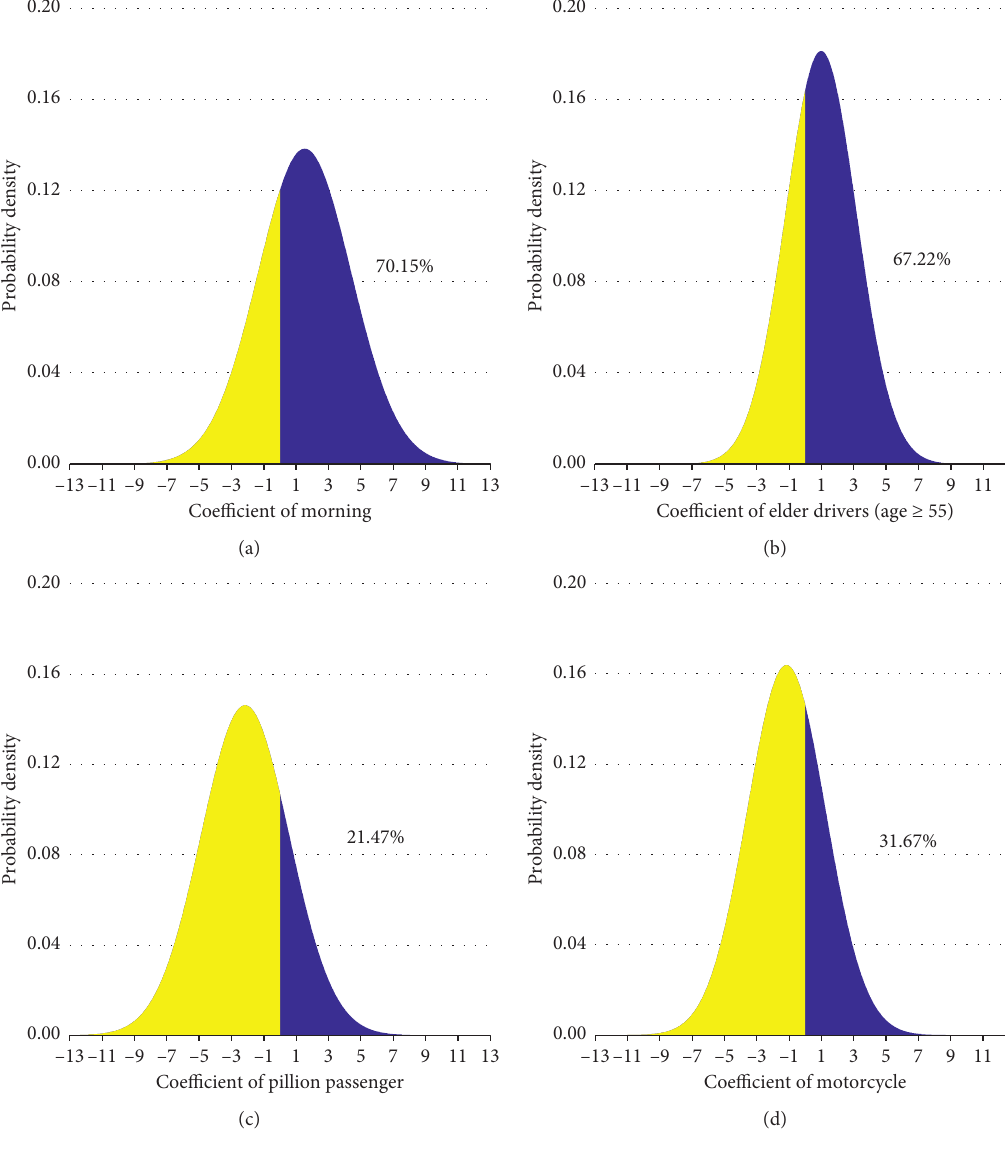
Figure 2: Plots of the estimated normal distributions of the random